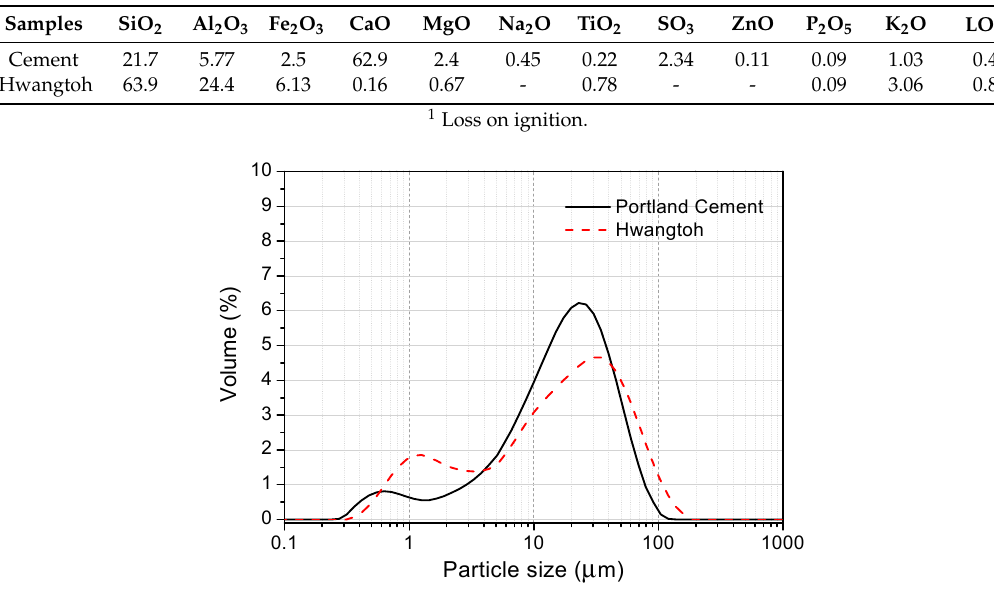
Figure 2. The distributions of the particle sizes of the tested materials.